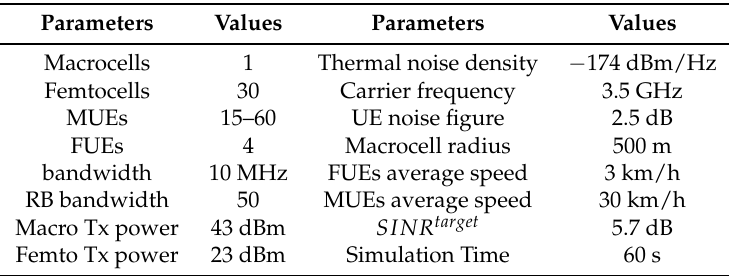
Table 3. Simulation